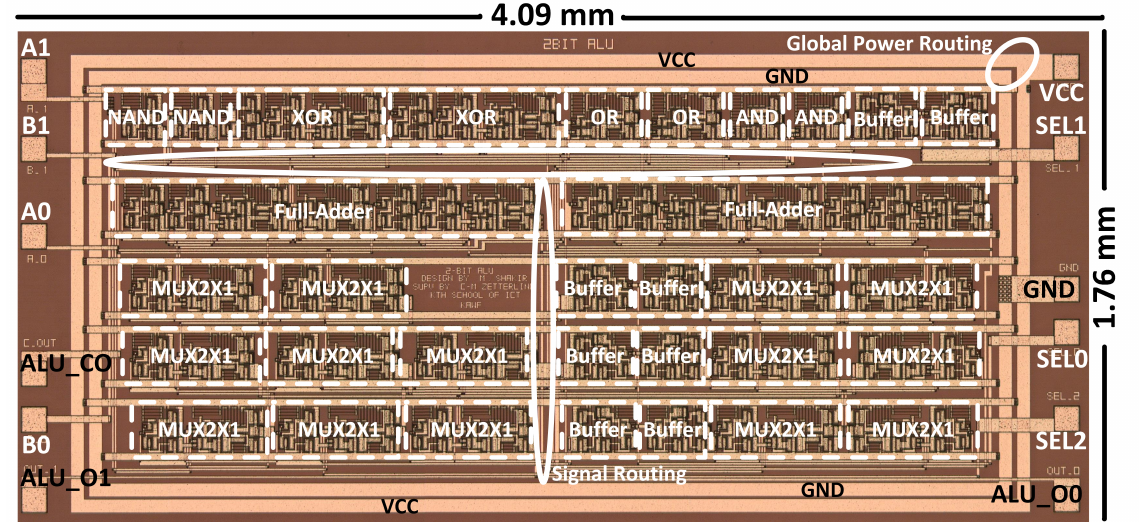
Figure 18. 2-bit ALU micro-photograph. The white markers on the layout optical image shows the standard cells name, integration density, power and signal routing schemes, in-out ports names and total area. The ALU is comprised of 720 on-chip integrated